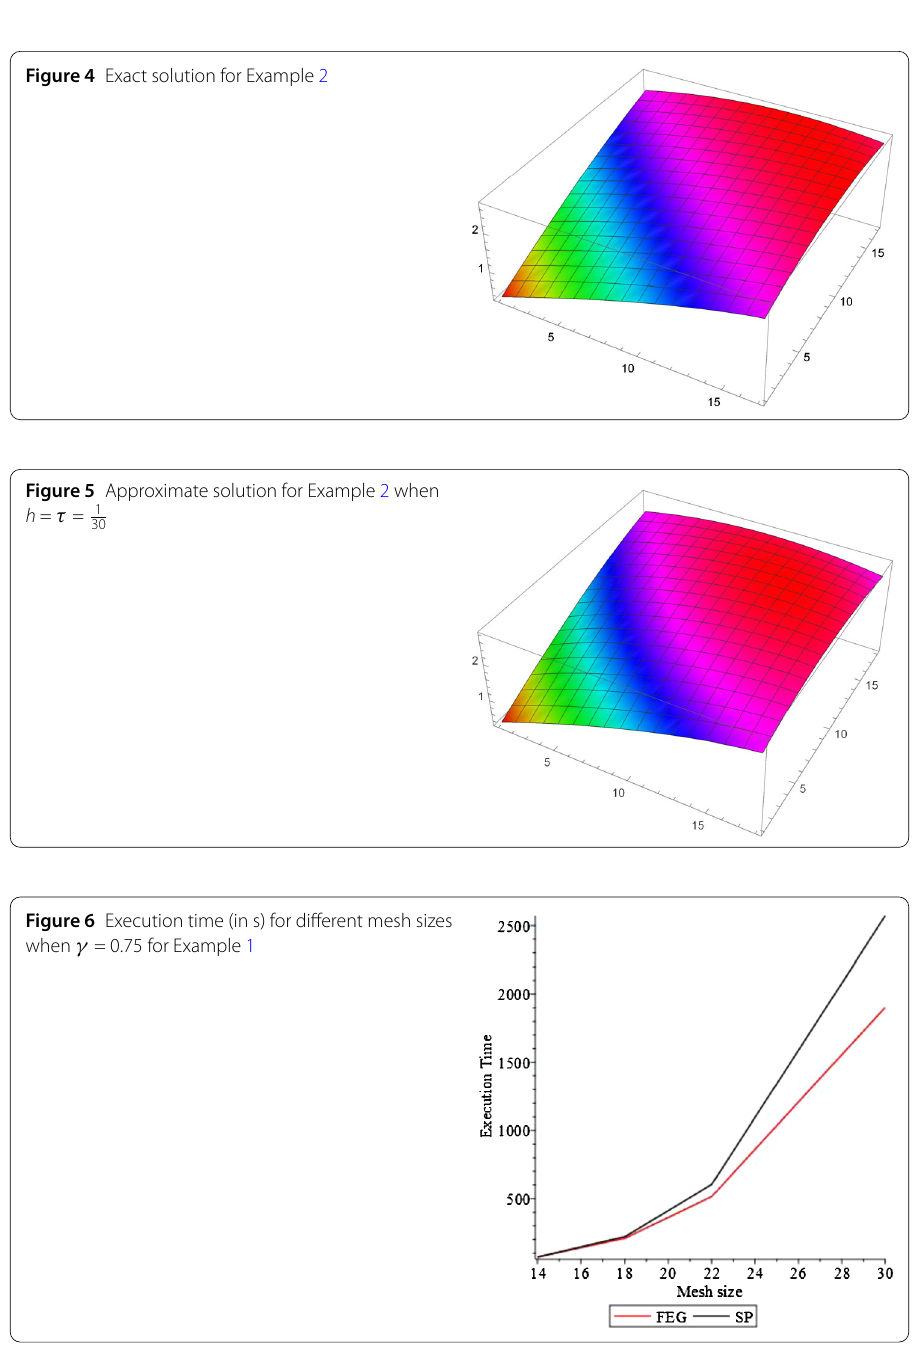
and with the exact solution w ( x , y , t ) = e t sin ( x + y